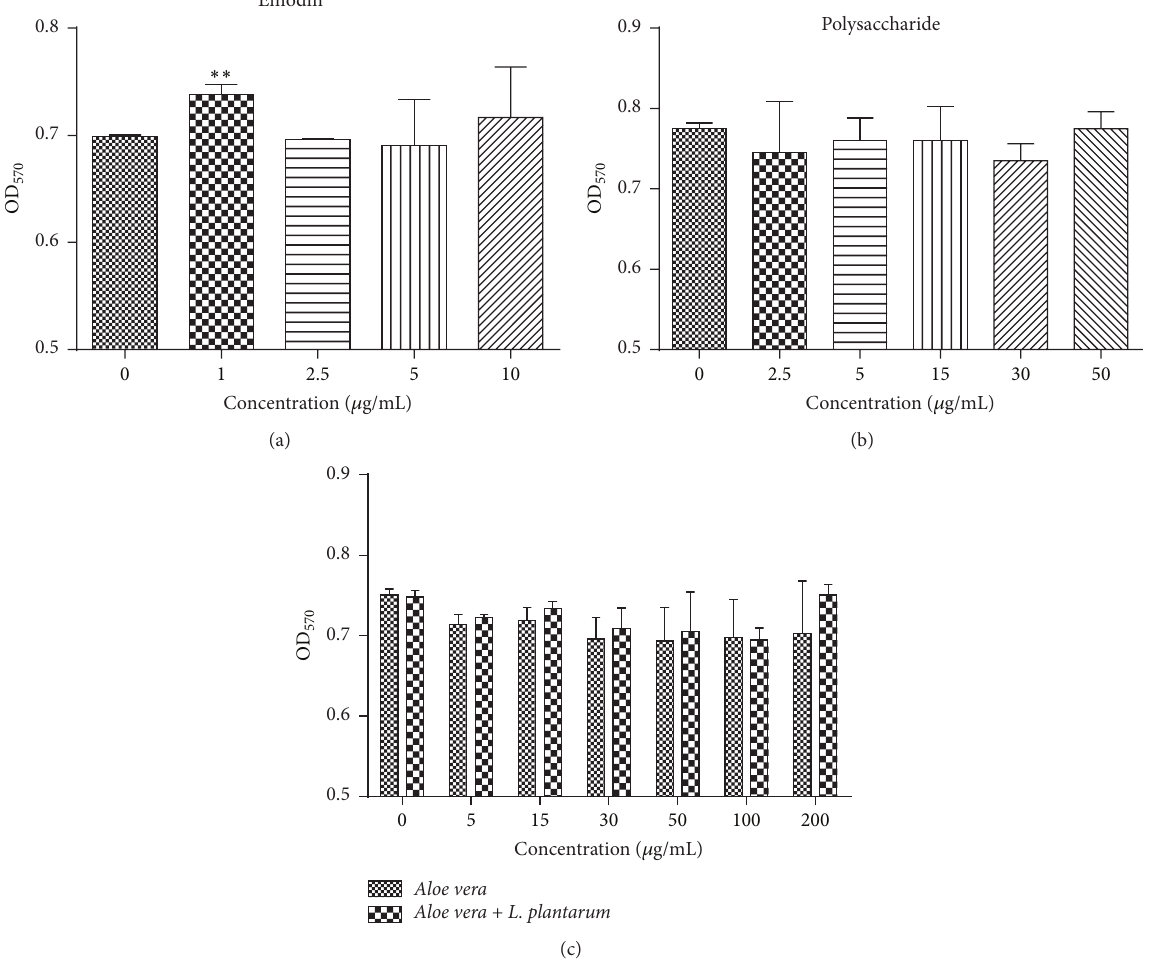
Figure 3: Different concentration of emodin (a), polysaccharide (b), Aloe vera and Aloe vera + L. plantarum (c) on the cell viability of RAW 264.7 cells using MTT method. Data are shown as the mean ± SD. ∗∗ 𝑃 < 0.01